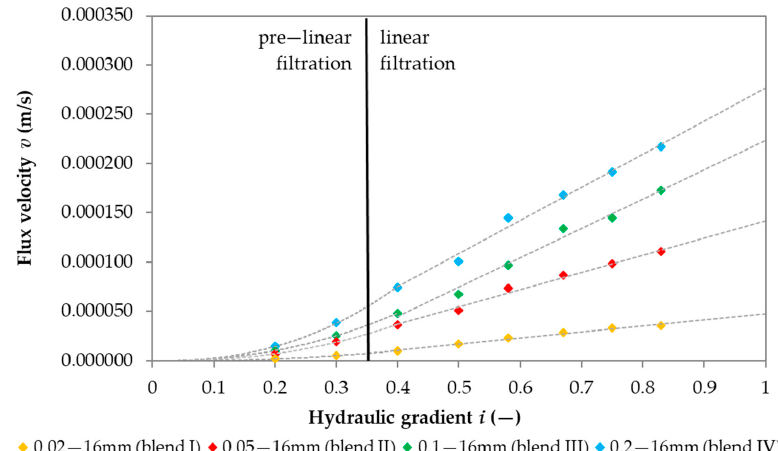
Figure 5. Results of average velocities of flow to a given gradient for different grain sizes.